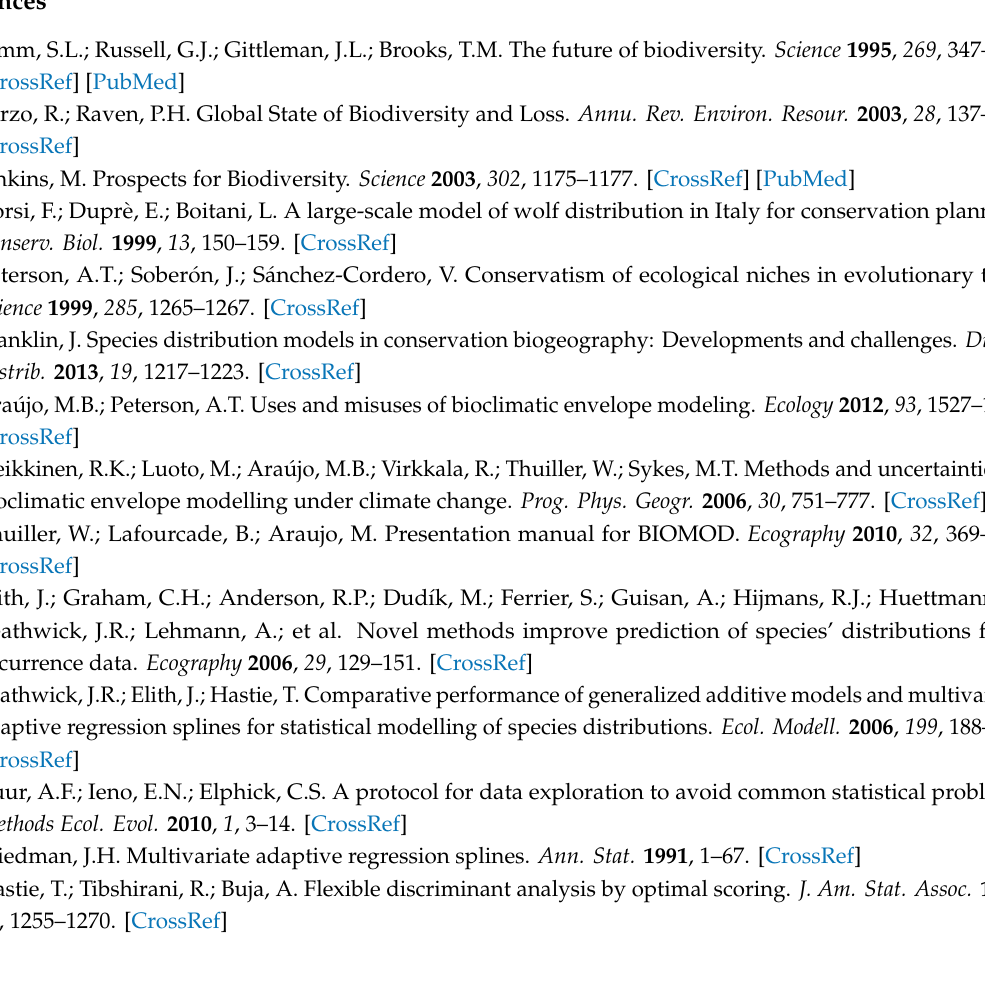
Table S1: Sensitivity comparison; Table S2: Specificity comparison; Table S3: AUC comparison; Table S4: Kappa statistic comparison; Table S5: TSS comparison; Figure S1: Habitat suitability visualization of Anas platyrhynchos; Figure S2: Habitat suitability visualization of Anas zonorhyncha; Figure S3: Habitat suitability visualization of Ardea cinerea ; Figure S4: Habitat suitability visualization of Cyanopica cyanus ; Figure S5: Habitat suitability visualization of Hyla japonica ; Figure S6: Habitat suitability visualization of Hynobius leechii ; Figure S7: Habitat suitability visualization of Hypsipetes amaurotis ; Figure S8: Habitat suitability visualization of Passer montanus ; Figure S9: Habitat suitability visualization of Rana dybowskii ; Figure S10: Habitat suitability visualization of Streptopelia orientalis